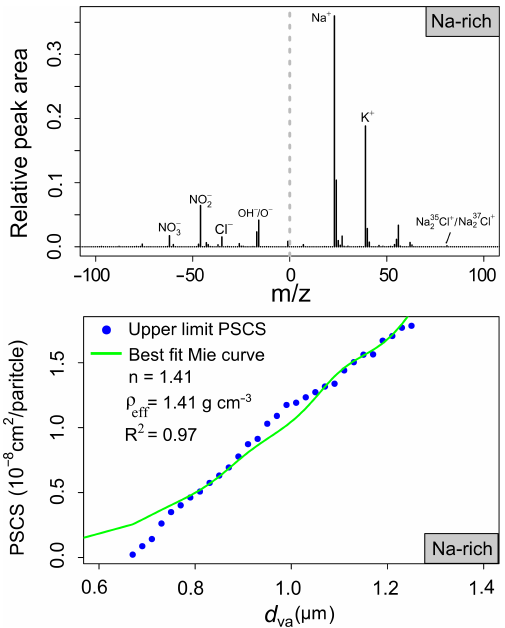
Figure 4. (top) Mass spectra and (bottom) measured and best-fit theoretical PSCS for Na-rich